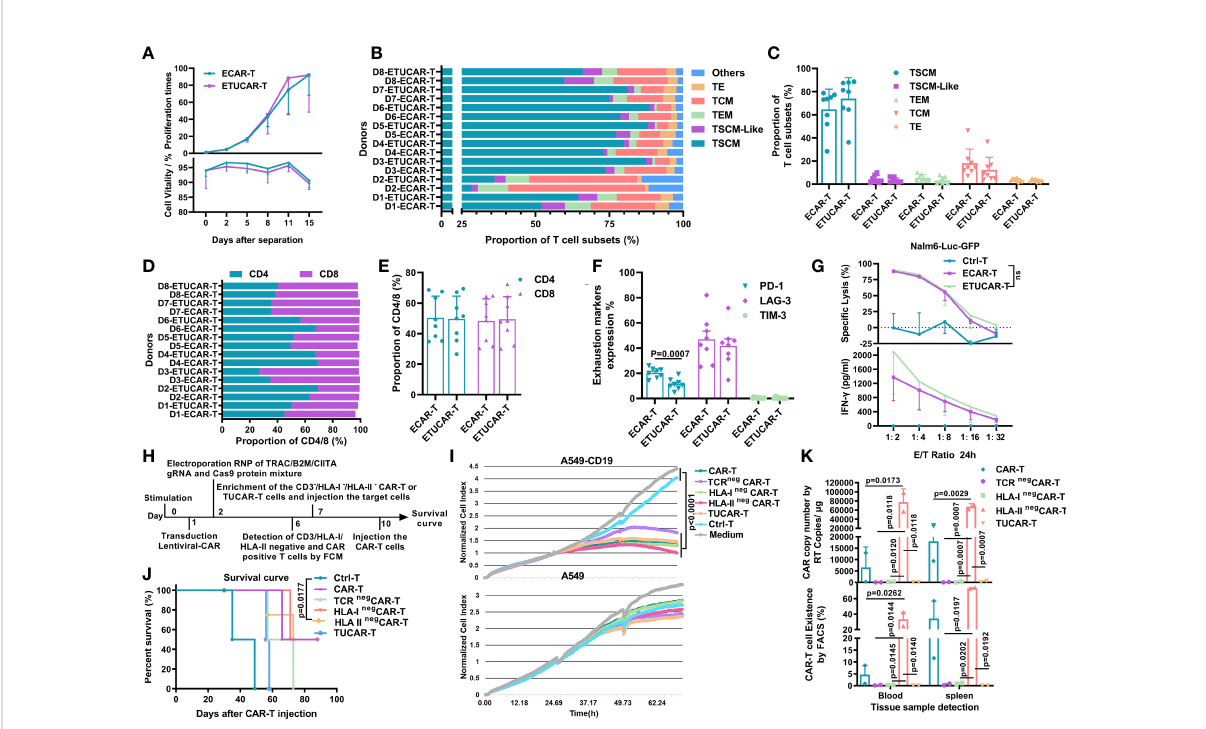
FIGURE 5 TCR de fi ciency in UCAR-T cells is the primary factor leading to inferior ef fi cacy compared to unedited CAR-T cells. (A) , Comparison of the ETUCAR-T and unedited ECAR-T cell proliferation times (top) and viability (bottom) ex vivo (n = 3). (B, C) , T-cell subset distributions (n=8). The classi fi cation criteria are as shown in Figure S4. (D, E) , Proportion of CD4/CD8 T cells (n = 8). (F) , Cell surface expression of exhaustion markers, programmed cell death protein 1 (PD-1), lymphocyte activation gene-3 (LAG3), and T-cell immunoglobulin and mucin domain-containing protein 3 (TIM-3) (n = 8). (G) , Representative data of cell lysis (top) and IFN- g secretion (bottom) in different E/T ratios (n=3). All data represent the mean ± SD. Statistical signi fi cance was determined with two-tailed, unpaired Student ’ s t -test. (H) , Flow chart of the generation of UCAR-T cells and the time nodes of other experiments. (I) , Cytotoxicity of different UCAR-T cells was assessed by measuring the normalized cell index using RTCA (n = 3). (J) , Survival curve of mice (n = 4). (K) , Peripheral blood and spleen from mice treated with CAR-T cells was obtained on day 30 for the presence of copies of the CAR transgene by RT-PCR (BBz) (top) and the Fluorescence-activated Cell Sorting (FACS) assay (CD45 (+)/CD3(+) CAR-T cells) (bottom). Data from two mice were shown. All data represent the mean ± SD. Statistical signi fi cance was determined by two-way ANOVA with Tukey ’ s correction for multiple comparisons (A) or two-tailed, unpaired Student ’ s t- test (C, E, F) , log-rank (Mantel – Cox) test (J) , or one-way ANOVA with Tukey ’ s correction for multiple comparisons (G, I, K)